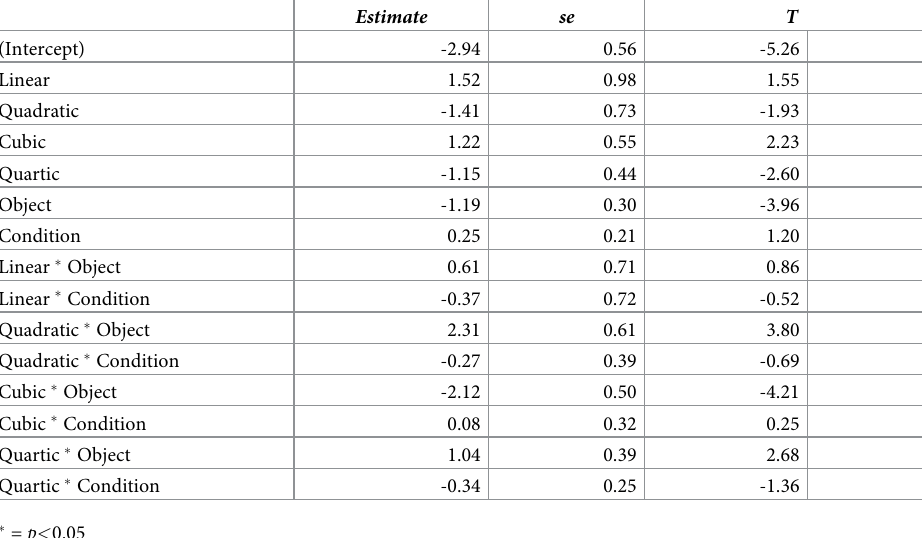
Table 4. Main and interaction effect in the quasi-logistic GCA mixed model